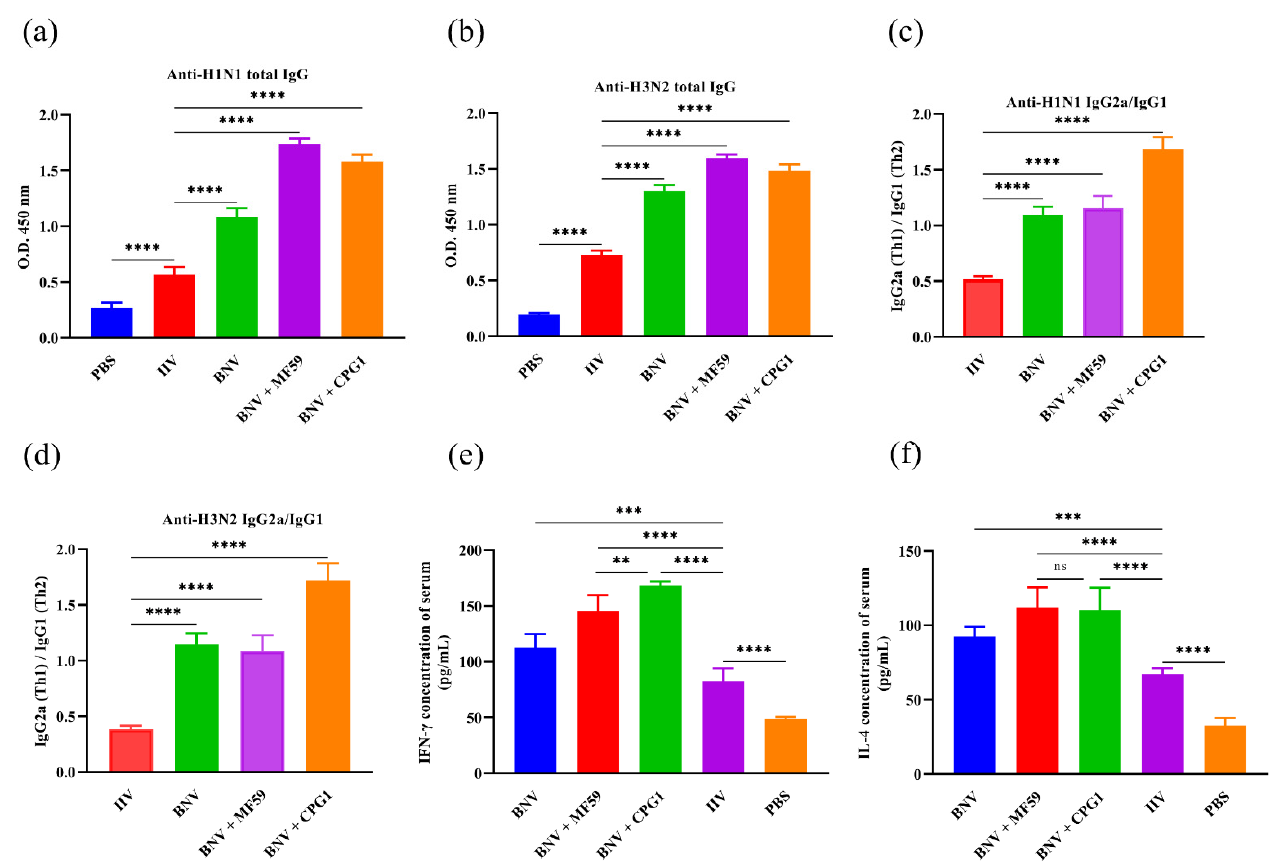
Figure 4. Virus-specific IgG ELISA and cytokine analysis in BNV immunized mice. ( a , b ) Swine influenza H1N1 and H3N2-specific IgG titers in serum two weeks after the final immunization. The minimum detectable dose of mouse IgG is less than 1.0 µg/mL. ( c , d ) Levels of IgG1 and IgG2a in serum of immunized mice were determined using ELISA two weeks after boost immunization. The minimum detectable dose of mouse IgG1 and IgG2a is less than 1.0 µg/mL and 0.1 µg/mL, respectively. ( e , f ) IFN- γ and IL-4 levels in serum from immunized mice were analyzed by mouse IFN- γ and IL-4 enzyme immunoassay kit. The minimum detectable dose of mouse IFN- γ and IL-4 is typically less than 1.0 pg/mL. Values are presented as mean ± standard deviation (S.D). Statistical significance analysis was performed using one-way ANOVA and then multiple comparison tests (** p < 0.01; *** p < 0.001; **** p < 0.0001; ns, p > 0.05), and n.s . indicates no significance between the two